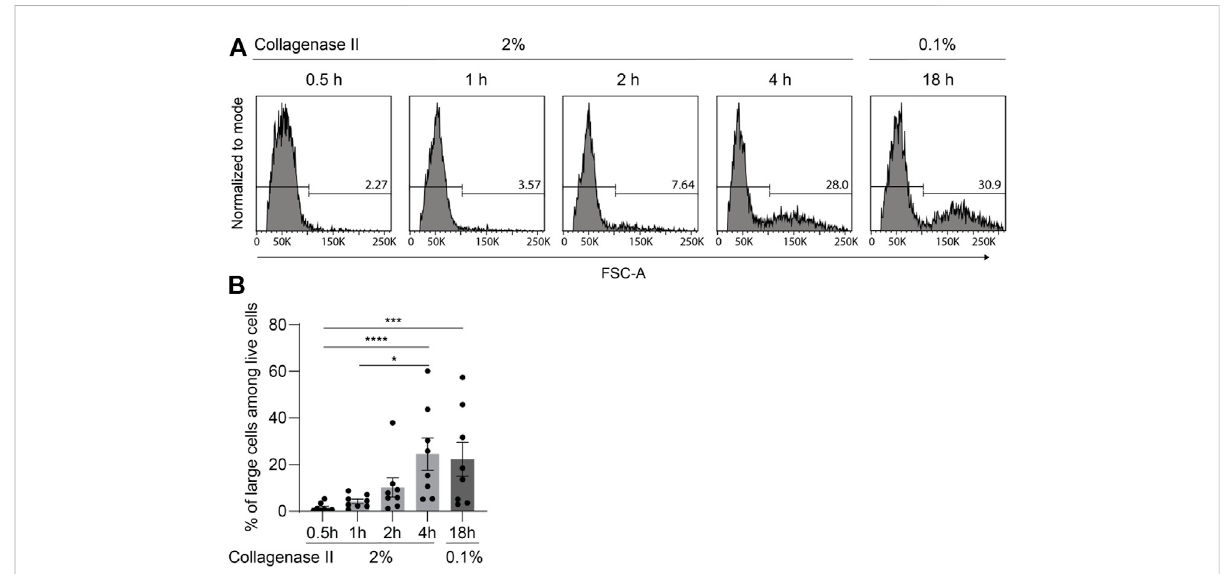
FIGURE 4 Large chondrocytes require prolonged digestion time for full release from cartilage matrix. After being fi nely minced, human articular cartilage tissue was divided equally into fi ve portions, and the samples were digested with 2% collagenase II for 0.5, 1, 2, or 4 h; or with 0.1% collagenase II for 18 h. (A) Chondrocyte cell size was determined by fl ow cytometry analysis. Representative FACS histograms and percentages are shown illustrating the cell size with the parameter forward light scatter (FSC-A). (B) Percentages of large cells among live cells are plotted (n = 8 patients). Data